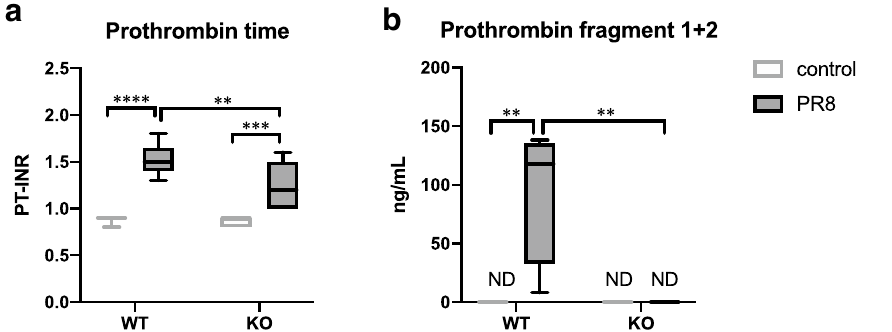
Figure 4. Effect of OLR1 on virus infection-induced blood coagulation abnormalities. WT and KO mice were intranasally inoculated with PBS control or PBS comprising PR8 virus, and whole-blood and serum samples were collected for the measurement of ( a ) PT-INR (WT control, n = 9; WT PR8, n = 9; KO control, n = 7; KO PR8, n = 7) and ( b ) prothrombin fragment 1 + 2 (n = 4), respectively, at 6 dpi. ( a and b ) Values are represented by box-and-whiskers plots as follows: the central line in the box is the median, the bottom and top lines of the box are the first and third quartiles, respectively, whiskers are the minimum to maximum values. In each panel, white and gray boxes indicate data from control and infected mice, respectively. ** p < 0.01, *** p < 0.0005, **** p < 0.0001, two-way ANOVA using a multiple-comparison correction. PR8, influenza virus A/Puerto Rico/8/34; WT, wild type mice; KO, Olr1 knockout mice; ND, not